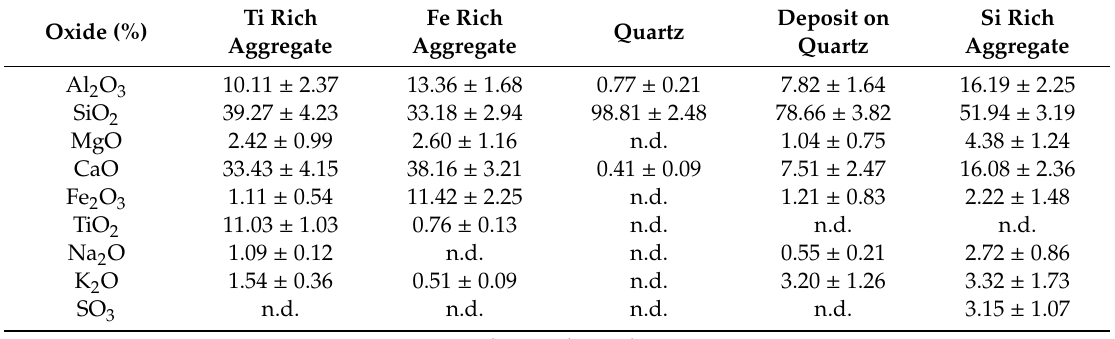
Minerals 2020 , 10 , 590 7 of 20